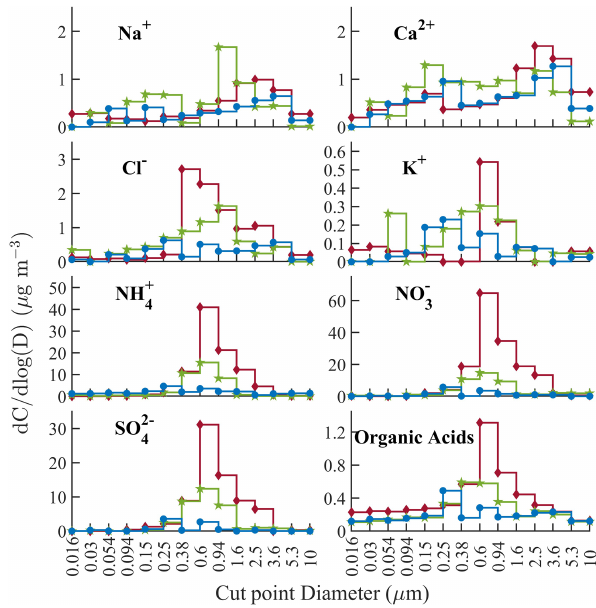
Figure 4. Size-resolved composition d C/ dlog( D ) for (red) pol- luted, (green) transition, and (blue) clear sample periods. Organic acids: sum of MSA, adipate, maleate, oxalate, phthalate. Sample set data were weighted by sample duration for the polluted and clean periods (note: transition period had just one set). Species that were below LOD in more than 50% of samples (see Table S1) are not